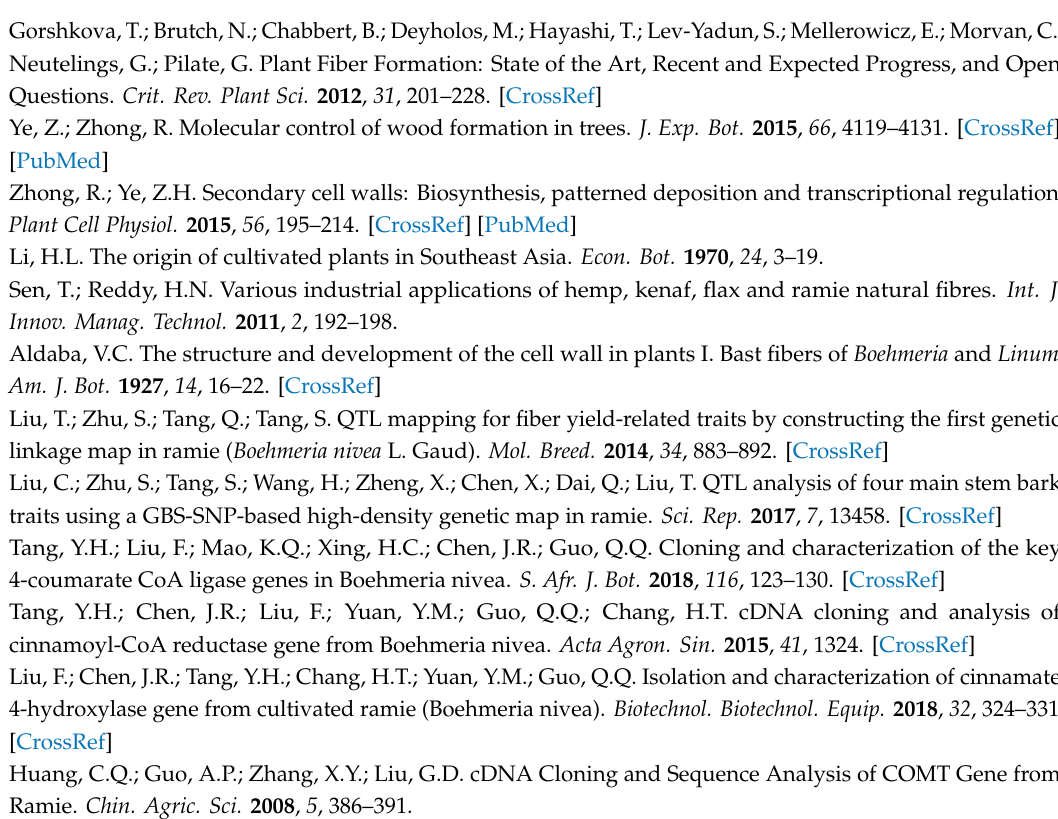
Table S1: Primers for amplifying three candidate genes and their putative promoters, Table S2: Di ff erentially expressed genes in the QTL